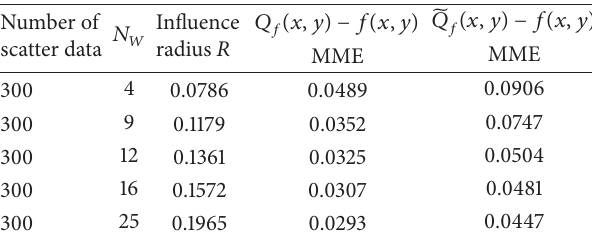
Table 2: The influence of influence radius on 𝑄 𝑓 (𝑥,𝑦) and Number of